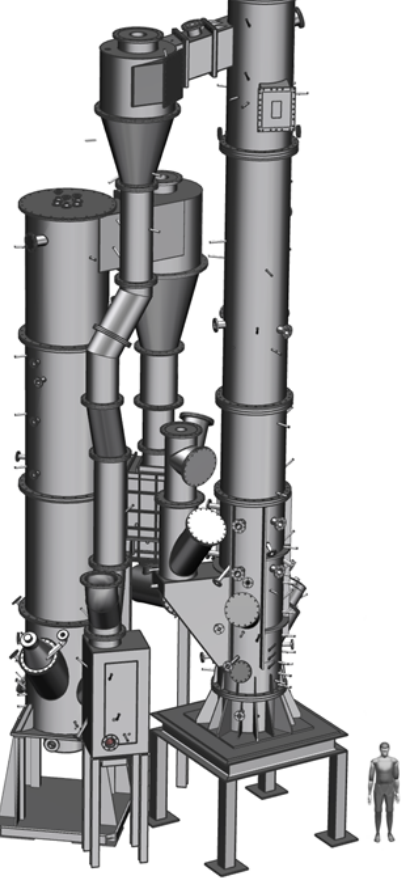
Figure 5. CLG reactor configuration including the main coupling